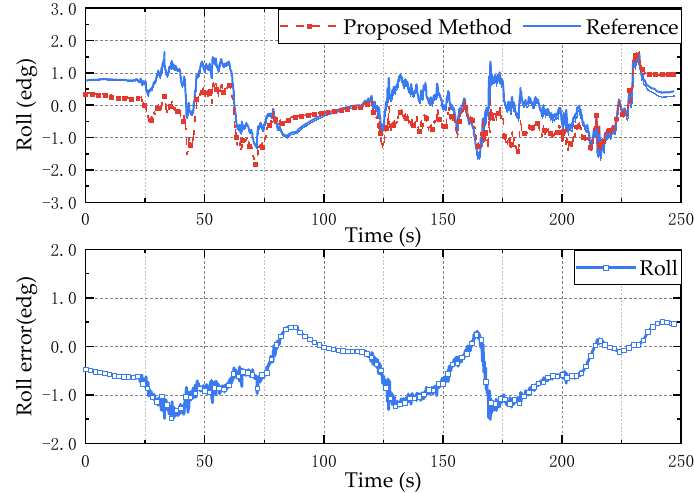
Figure 16. Roll angle anti-interference test results. The above is the estimation result of the proposed method, and the bottom is the error between the estimated value and the reference value.